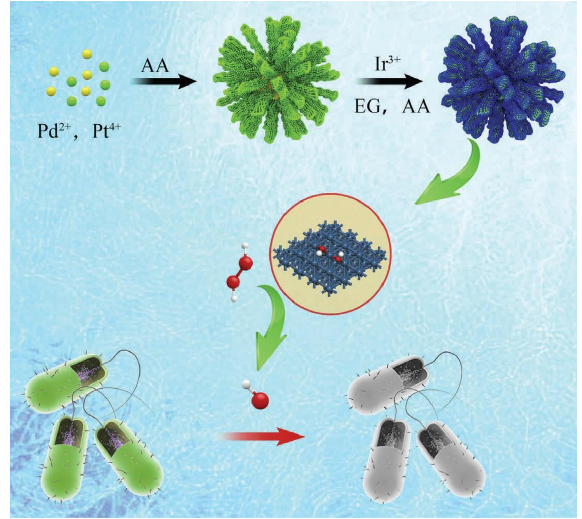
Scheme 1: Te possible antimicrobial mechanism of DA-PPI